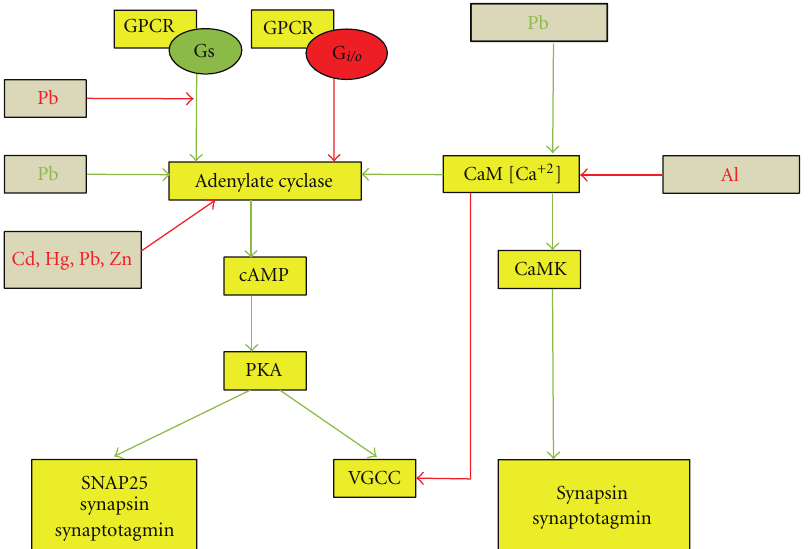
Figure 2: E ff ects of Metals on the cAMP Signaling Pathway at the Presynaptic Terminal (green: activation/increase, red: inhibition/decrease). GPCR’s are coupled to G s or G i / o , where G s stimulates adenylate cyclase and G i / o inhibits PKA. PKA phosphorylates Ca 2+ -channels, thereby enhancing the influx of Ca 2+ and this increases the release of neurotransmitters. PKA phosphorylates SNAP-25 and this leads to a larger pool of readily releasable vesicles. The cAMP-system appears to enhance the release of neurotransmitter in response to a stimulus. Metals act at di ff erent points in this pathway either enhancing certain processes or inhibiting some. A green color indicates an activation or an increase, and a red color indicates an inhibition or a